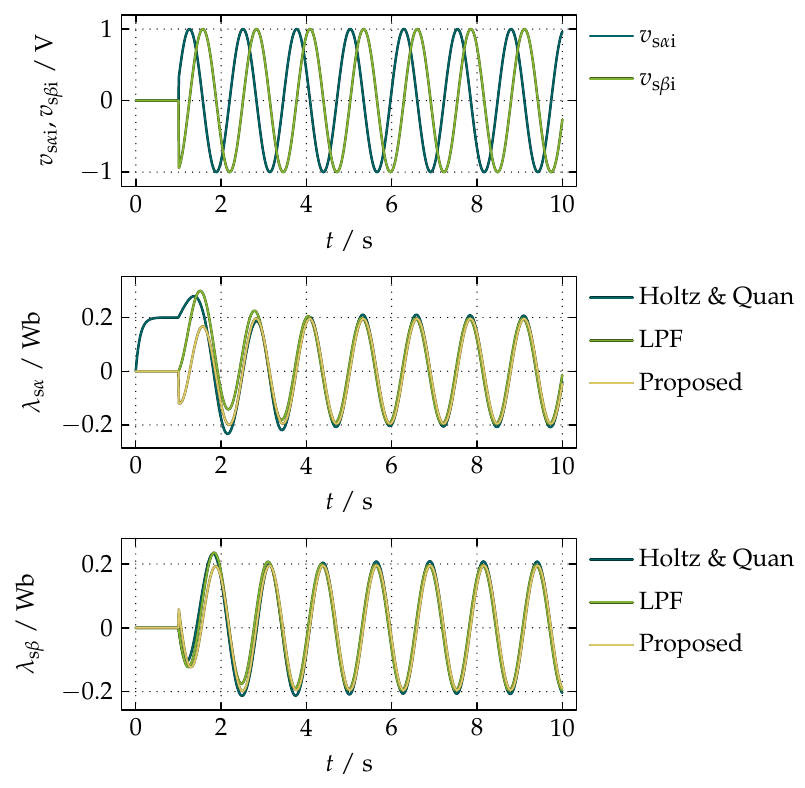
Figure 13. A comparison of the simulation results of the proposed compensation, the standard method with LPFs presented in [3–8], and the method by Holtz and Quan in [18,19] for a sudden step in the amplitudes of v s α i and v s β i